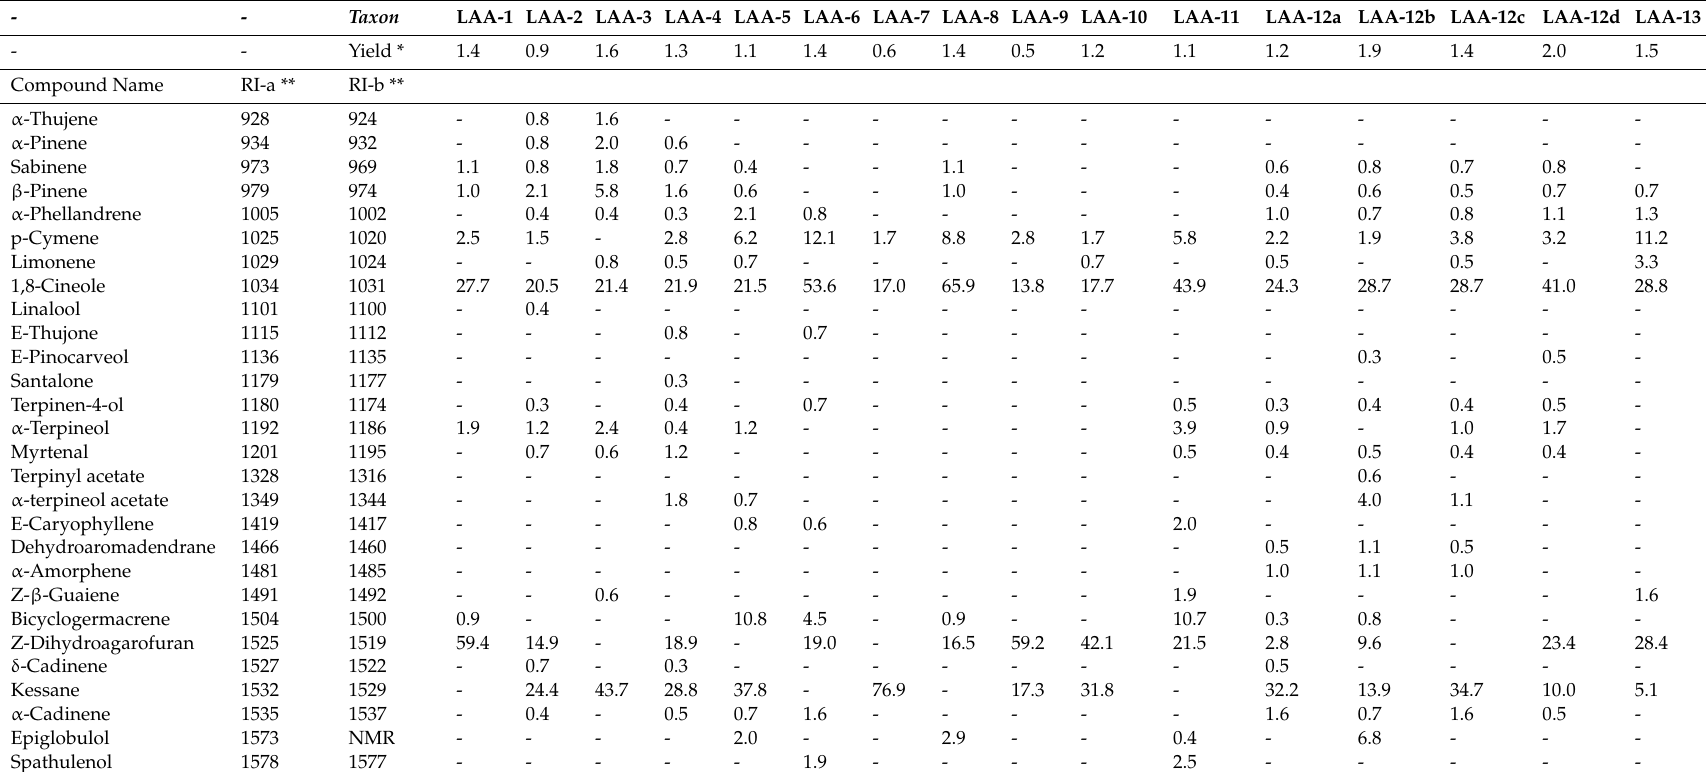
Table 1. Chemical character of essential oils from Prostanthera lanceolata